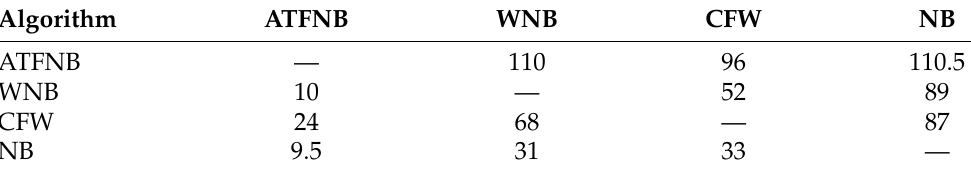
Table 11. Ranks of the Wilcoxon test with regard to ATFNB on Flavia dataset.